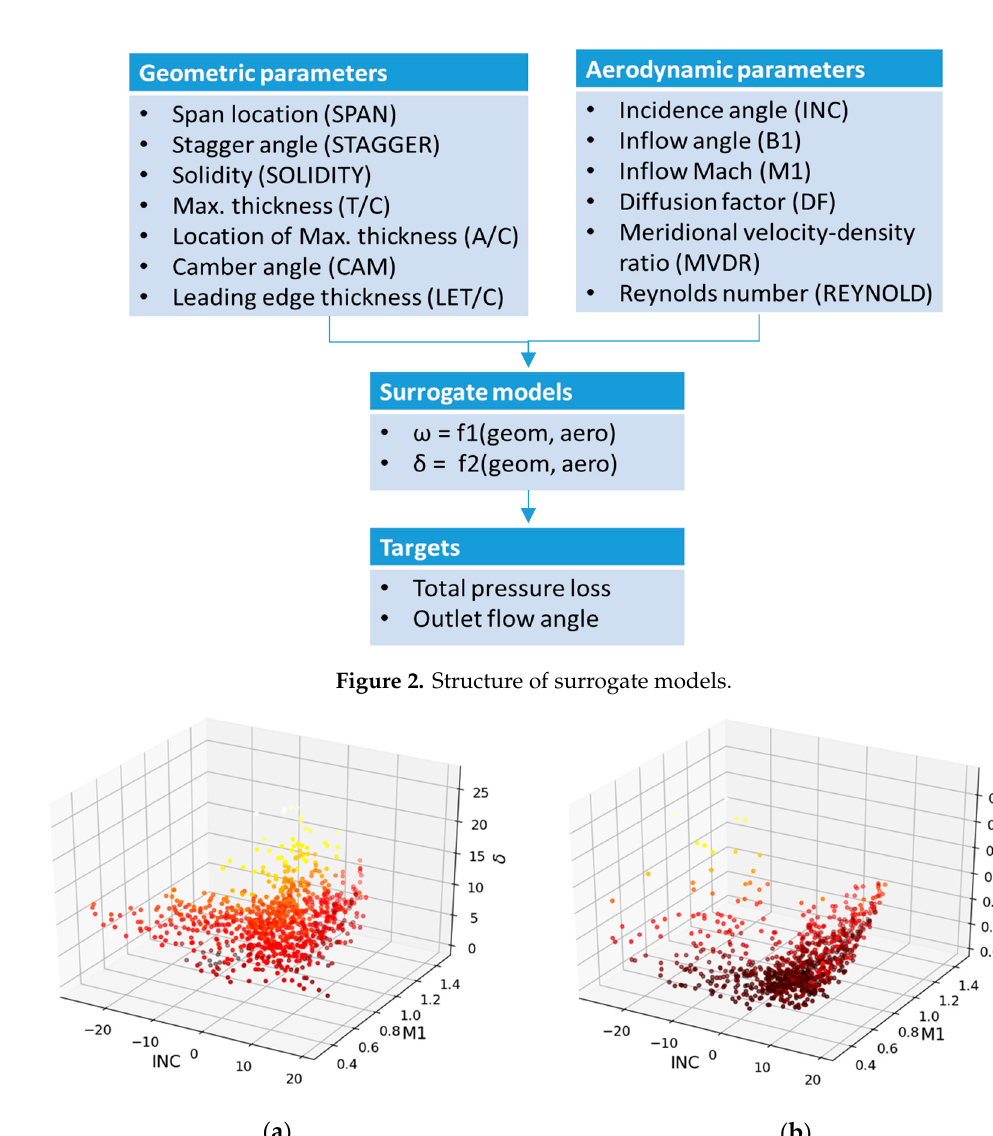
Figure 3. Distribution of experimental data: ( a ) The distribution of deviation angle; ( b ) The distribution of total pressure loss.